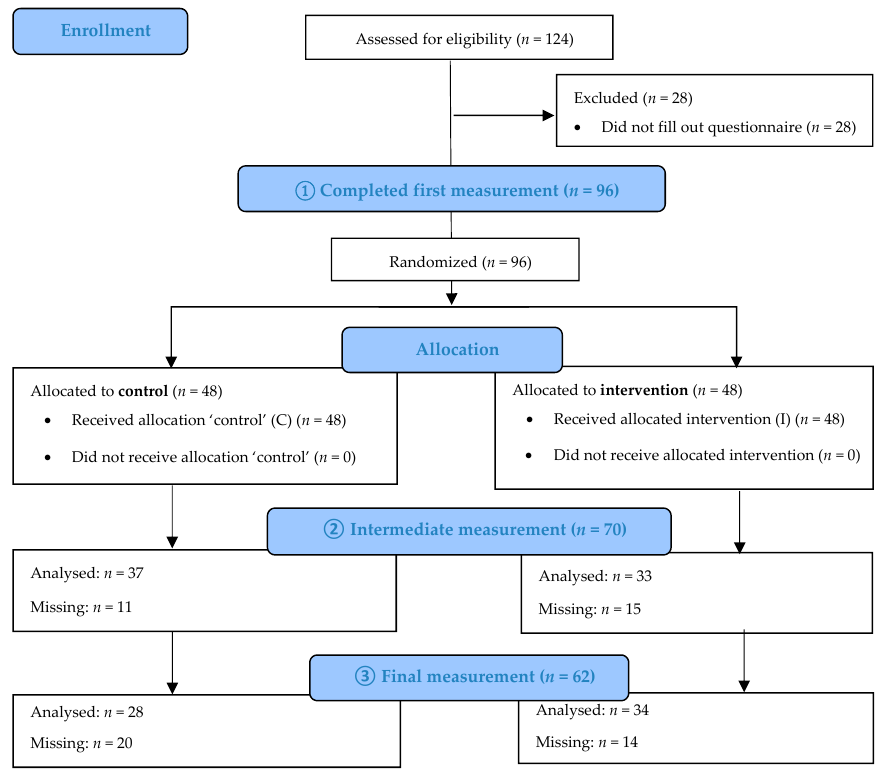
Figure 1. Flow diagram of the enrollment, allocation, follow-up, and analysis process.